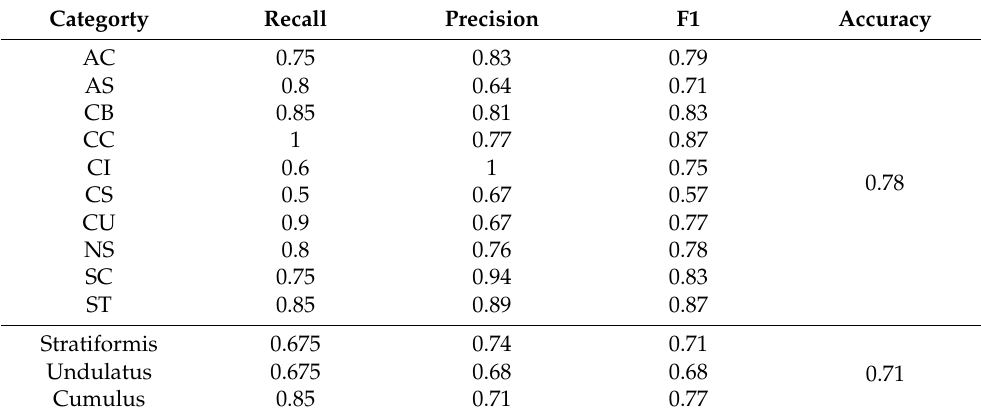
Table 2. Performance evaluation of Gamma datasets with multiple classification